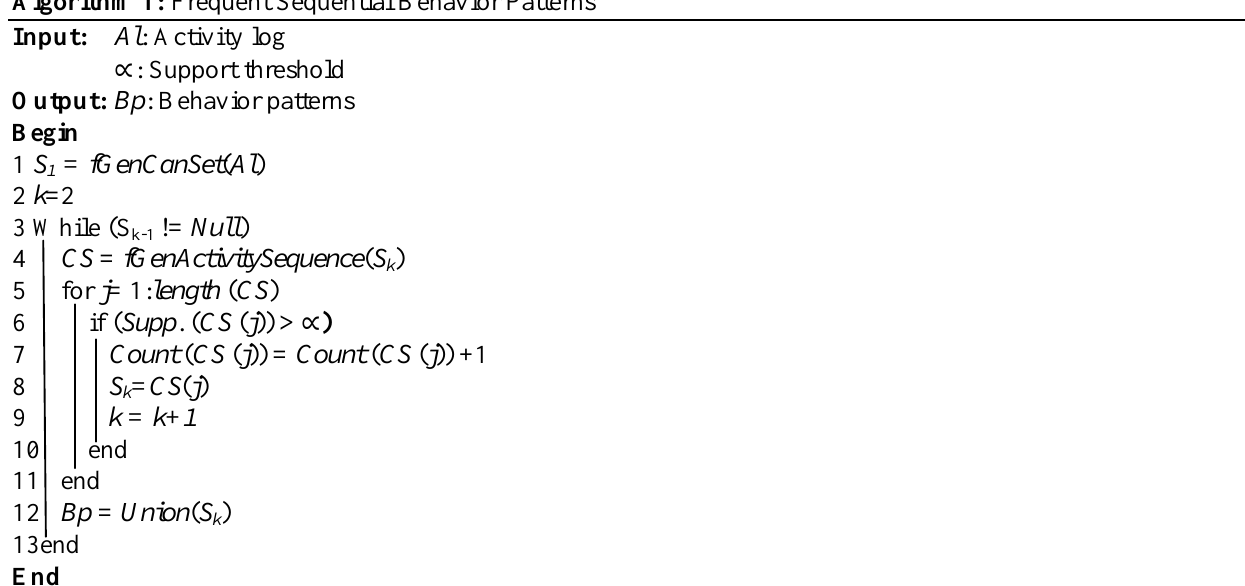
Algorithm 1: Frequent Sequential Behavior